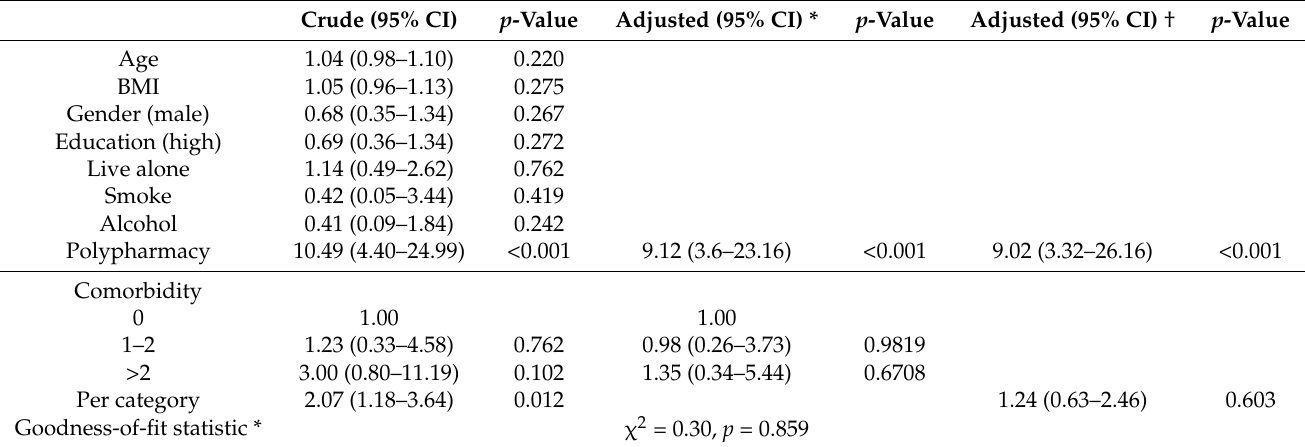
Table 2. Regression model of the 5-item Fatigue, Resistance, Ambulation, Illness, and Loss of Weight scale.